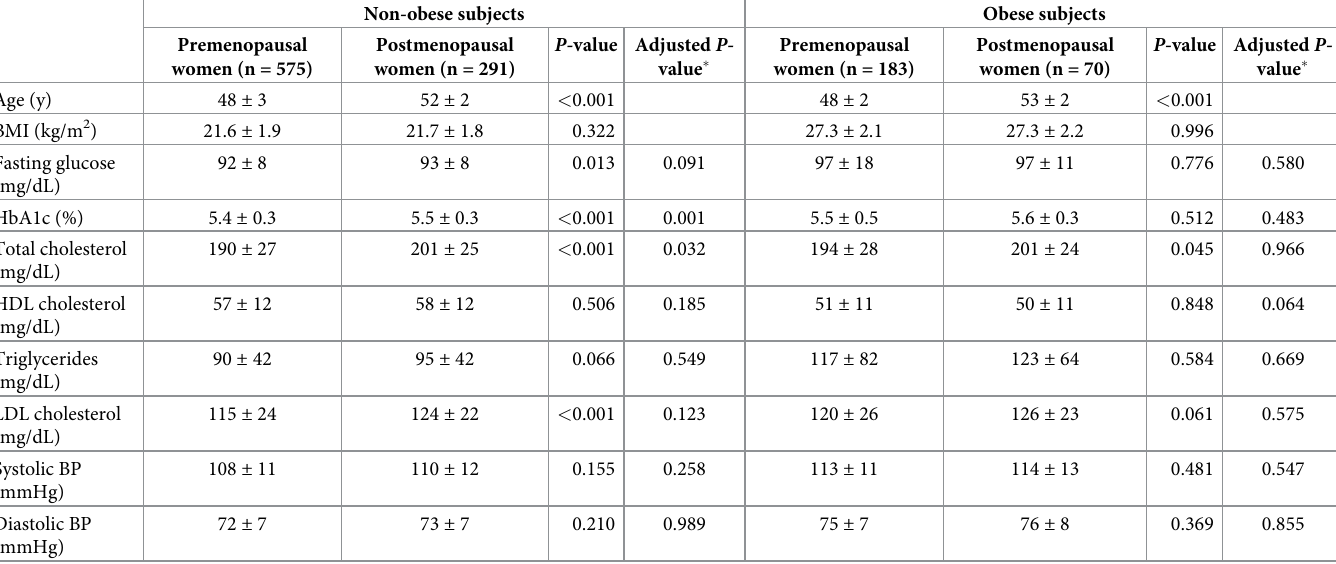
Table 2. Comparison of characteristics and cardiovascular risk factors in study participants according to the degree of